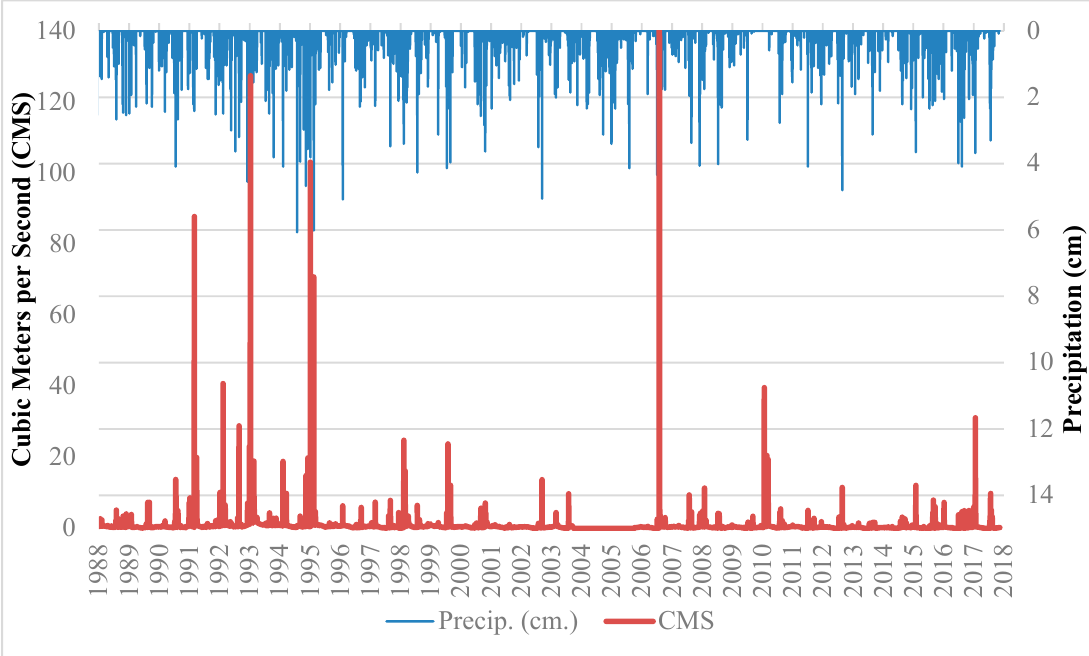
Figure 2. Rainfall-runoff response portrayed in hyeto-hydrograph at USGS stream gage station #09473000, Aravaipa Creek near Mammoth Springs.